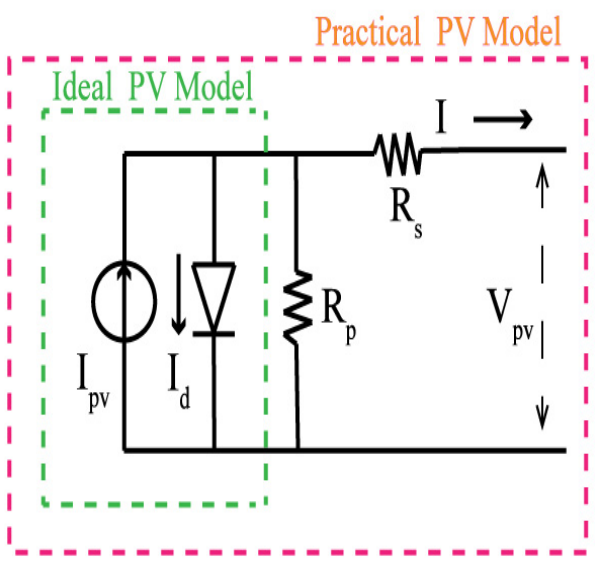
Figure 1. Single diode PV